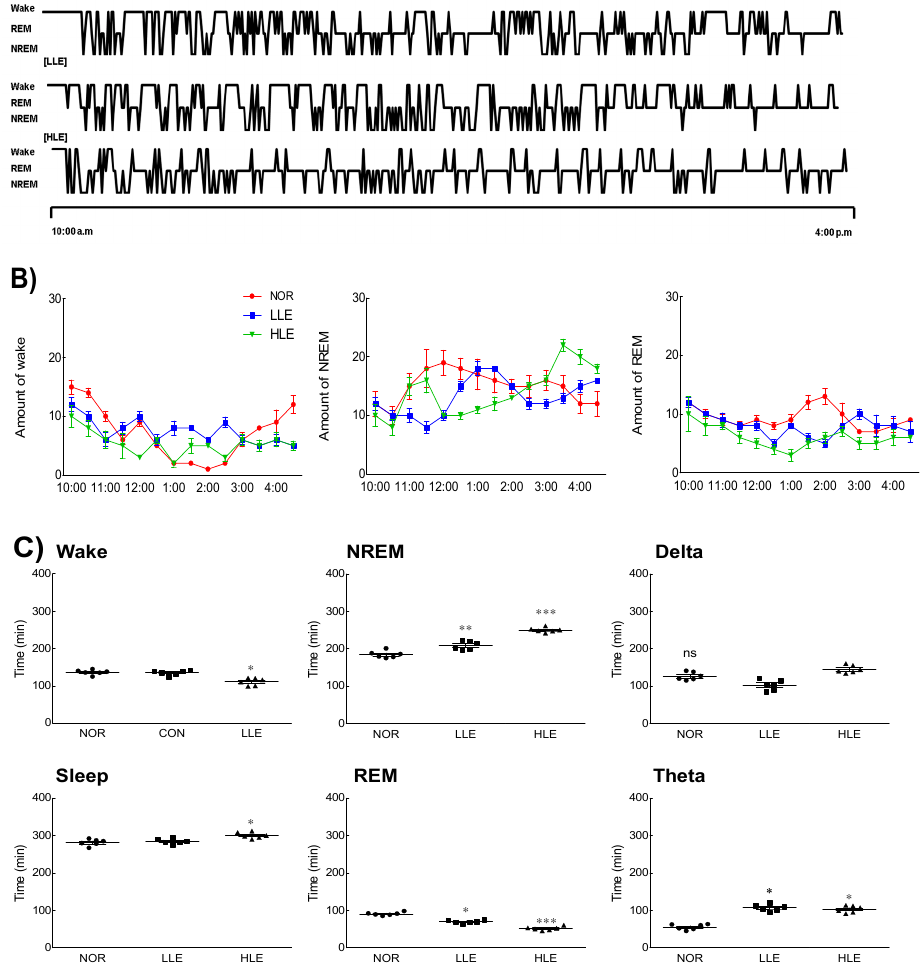
Figure 2. Effects of the ethanol extracts of lotus leaf on sleep architecture in rat ( n = 6/group). ( A ) Hypnograms that represent concatenated 1 min epochs of EEG activity, scored as wake, rapid eye movement sleep (REM), non- rapid eye movement sleep (NREM) sleep on day 9th. ( B ) Changes on wake, REM, NREM after oral injection for 7 h ( C ) Average time of awakening, sleep, non-REM, REM, delta waves, and theta waves in SD rats. NOR: normal group; LLE: low dose of ethanol-extracted lotus sample-treated group (150 mg/kg); HLE: high dose of ethanol-extracted lotus sample-treated group (300 mg/kg); REM: rapid eye movement sleep; NREM: non-REM sleep; ns, not significant. Values are means ± standard error of the mean for each group. * p < 0.05, ** p < 0.01, and *** p < 0.001 vs. NOR.